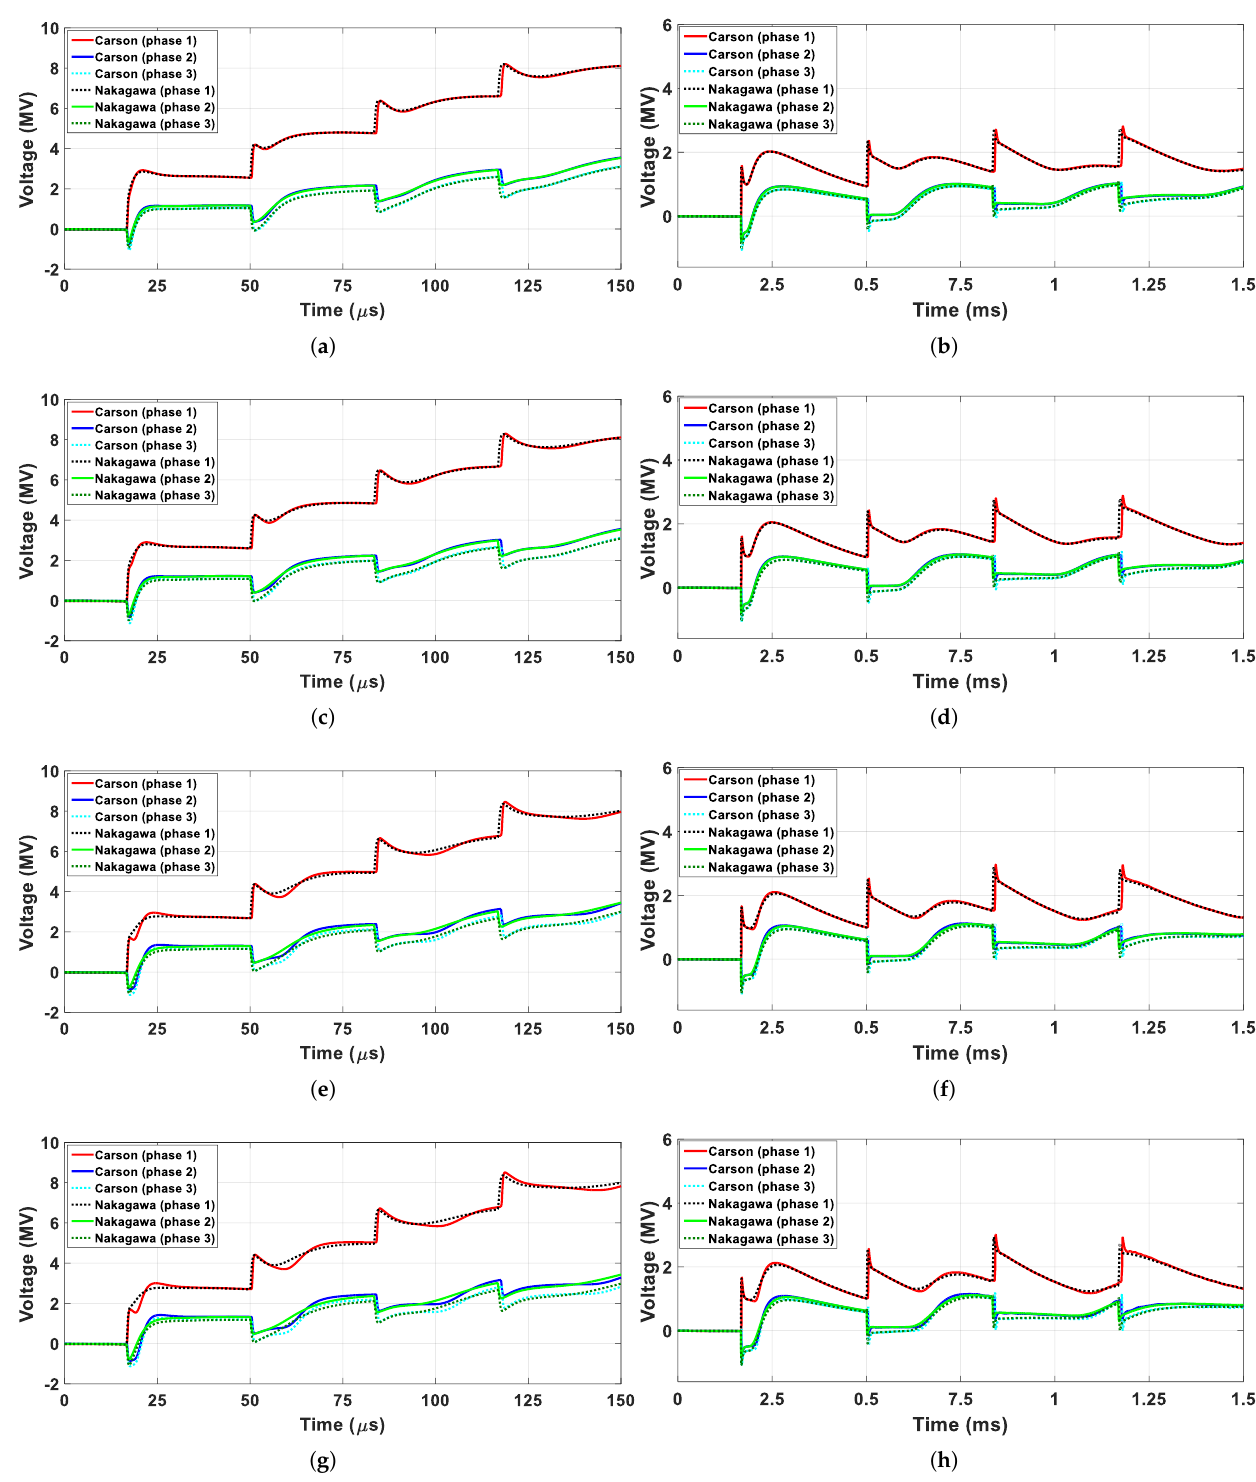
Figure 13. Transient voltages at the receiving end of the TL of Figure 12 when the current source is the subsequent stroke of Section 4.1, and the length of the line and soil resistivity are, respectively, ( a ) 5 km–500 Ω · m, ( b ) 50 km–500 Ω ·